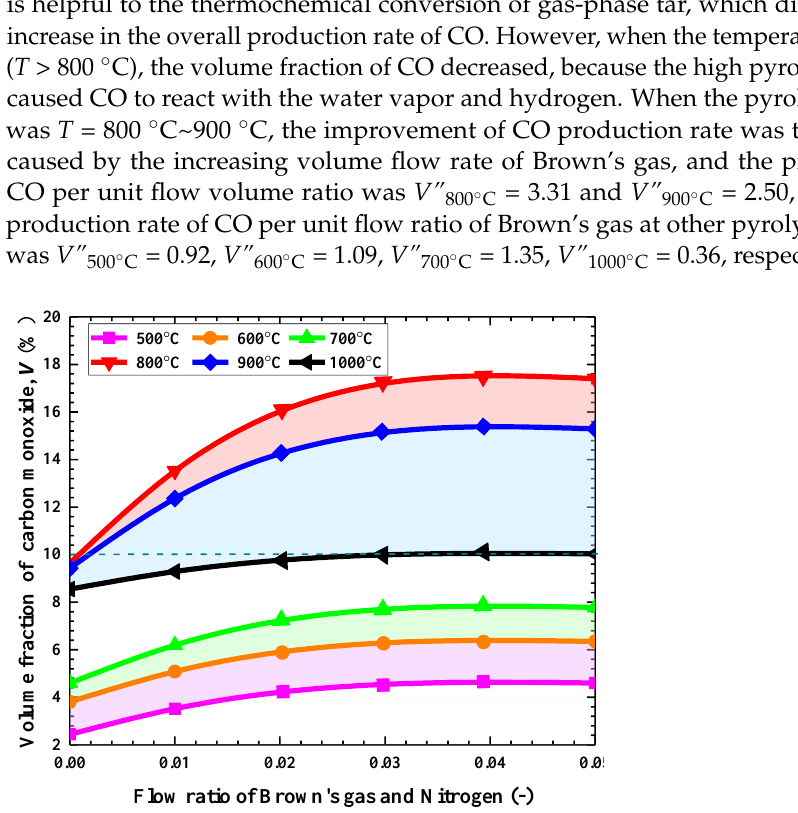
Figure 12. Relationship between the CO volume fraction and the flow volume ratio of Brown’s gas to nitrogen in pine wood pyrolysis.